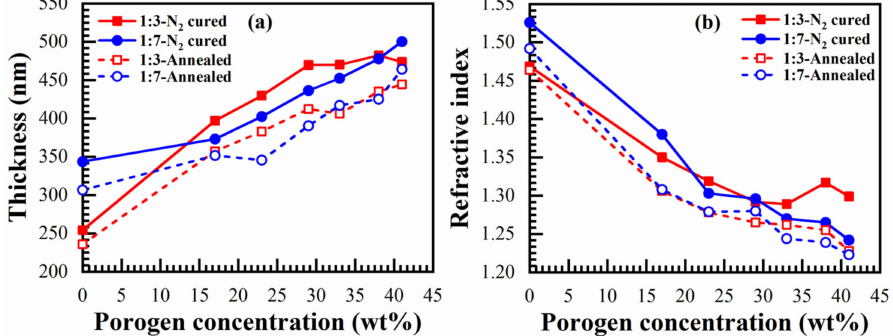
Figure 20. Effect of annealing at 600 ◦ C for 30 min (annealed) on ( a ) thickness and ( b ) refractive index of 1:3- and 1:7-benzene bridge ratio materials N 2 -cured at 400 ◦ C for 60 min (just N 2 -cured) with different porogen